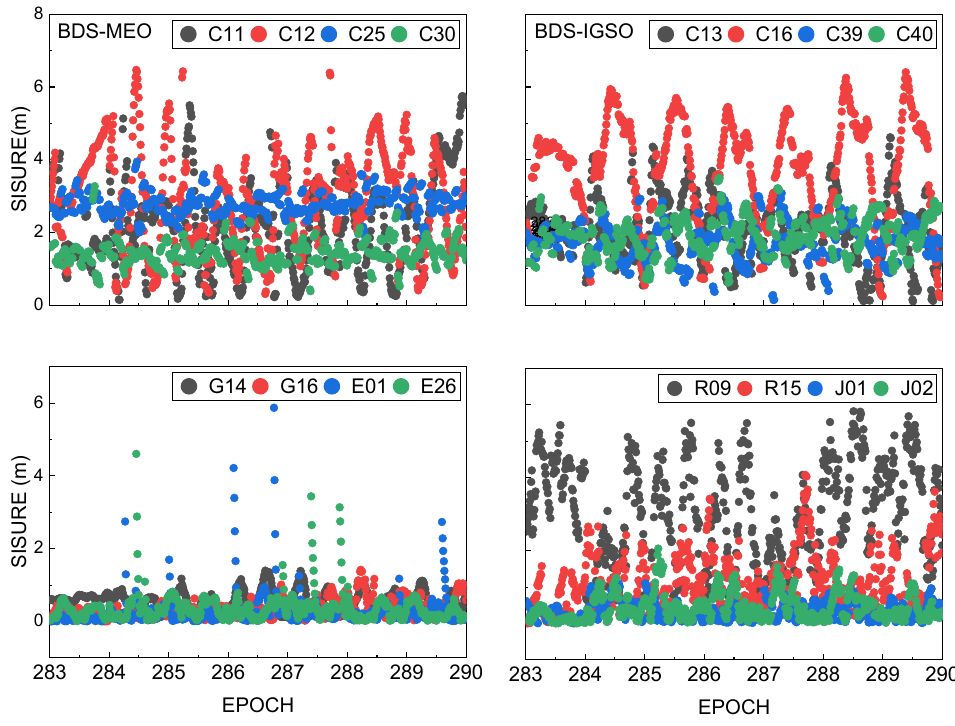
Figure 8. SISIRE of GPS/BDS-2/BDS-3/GLONASS/Galileo/QZSS.